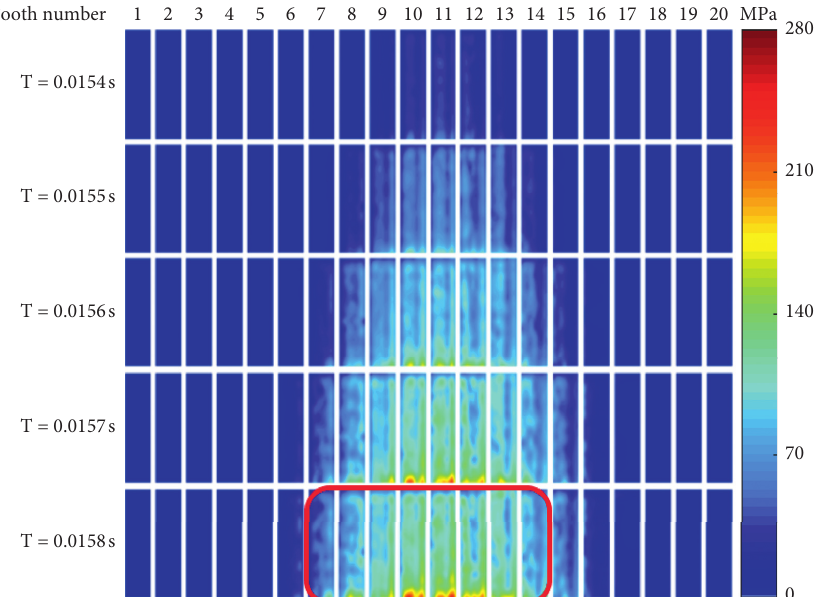
Figure 19: Real-time stress distribution of the contact area on axle spline surface under the identical loading case, at δ �